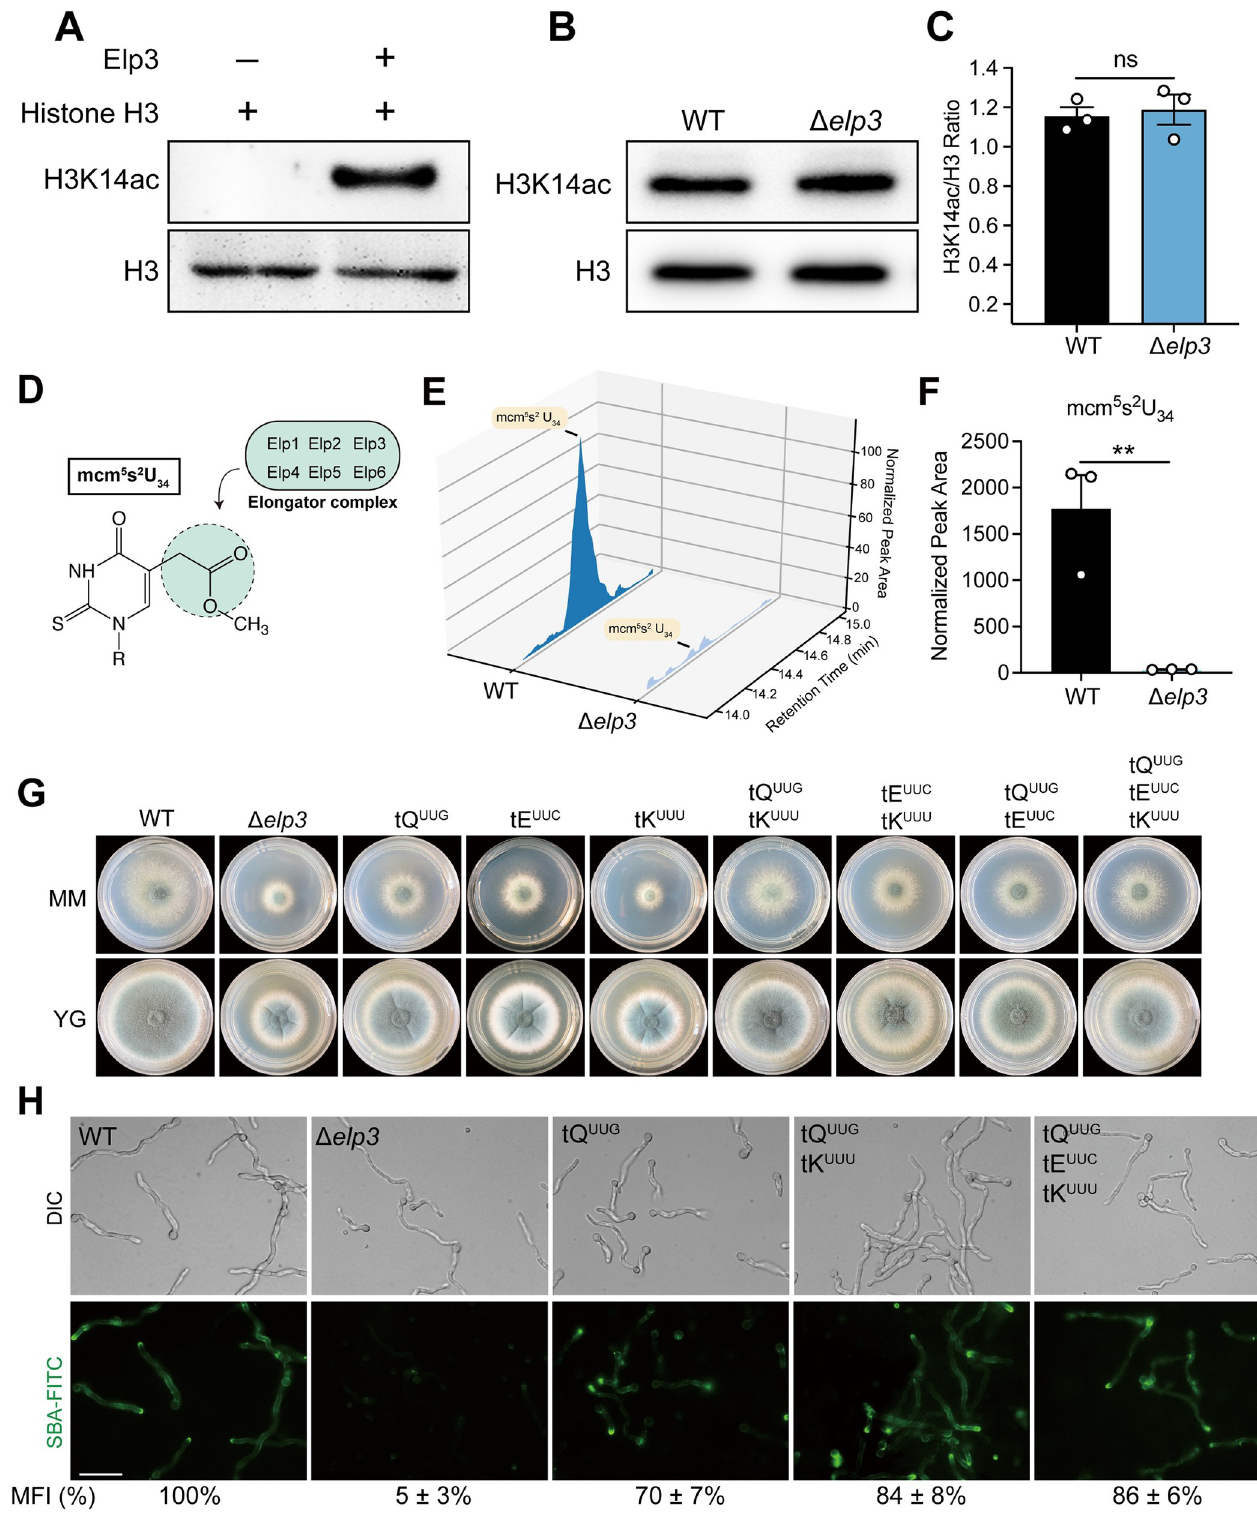
Fig 6. Defective phenotypes of the Δ elp3 mutant are associated with tRNA modification defects. (A) In vitro histone acetyltransferase assays. Purified Elp3 was incubated with HeLa core histones as substrates. Acetylation levels were measured by western blotting using H3K14ac antibodies. (B) Western